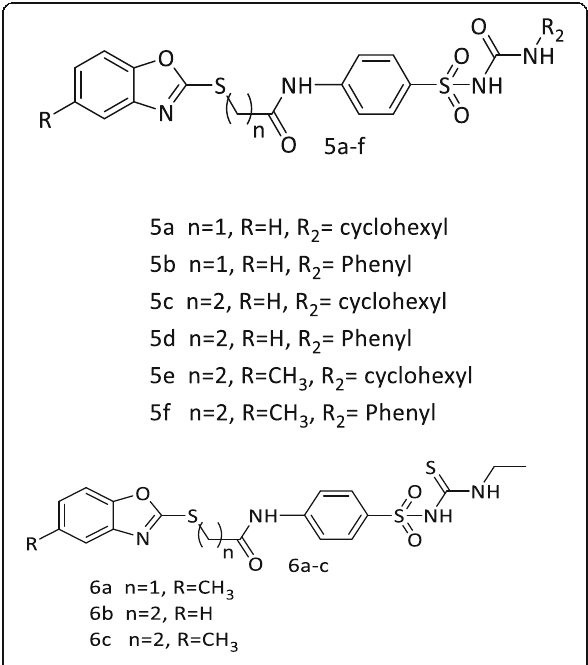
Fig. 29 Benzoxazole-sulphamide hybrid compounds